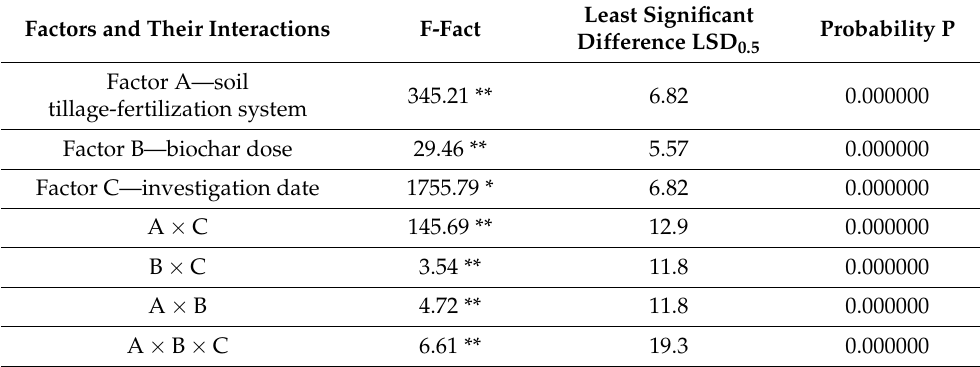
Least Significant Probability P Difference LSD 0.5 345.21 **